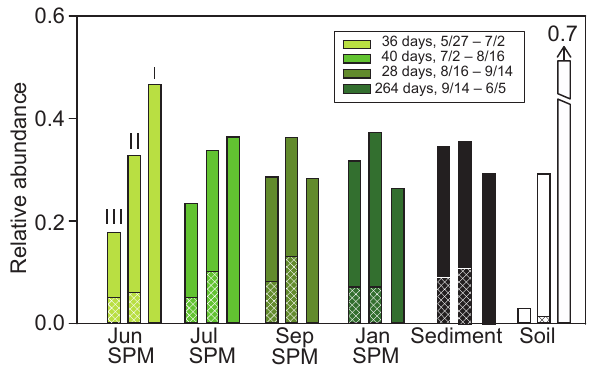
Figure 2. Temporal variation in the relative abundance of group I, II, and III brGDGTs in SPM (green shaded bars), sediment (black bars), and catchment soil samples (white bars). Sediment and soil samples were collected in spring of 2014. Green shaded bars for SPM samples reflect averages for each date samples were collected, measured in July 2014 (lightest green), August 2014, September 2014, and June 2015 (darkest green). For each cate- gory, brGDGT groups III, II, and I are shown in that order (left to right). Lines in each bar represent the relative abundance of 5- and 6-methyl brGDGTs, with cross hatching representing 6-methyl